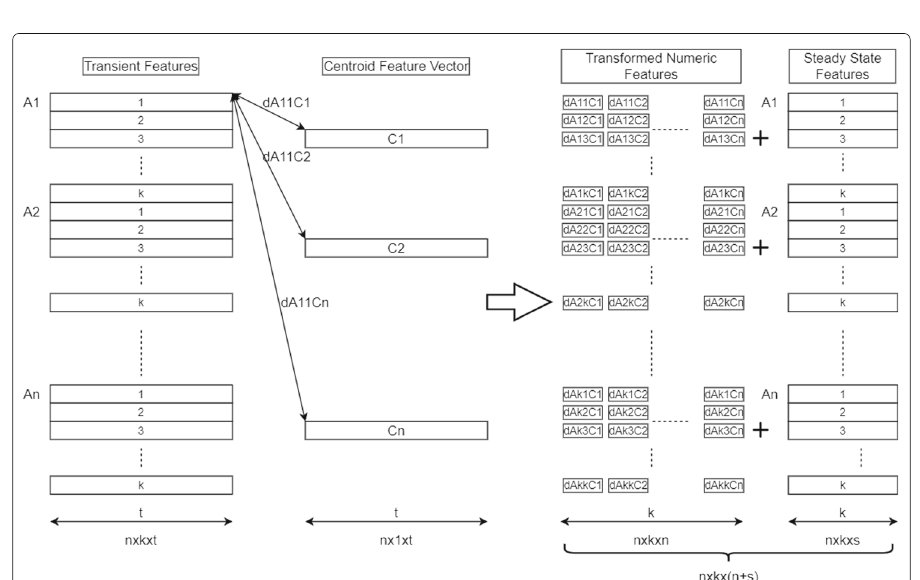
Fig. 4 Feature Fusion